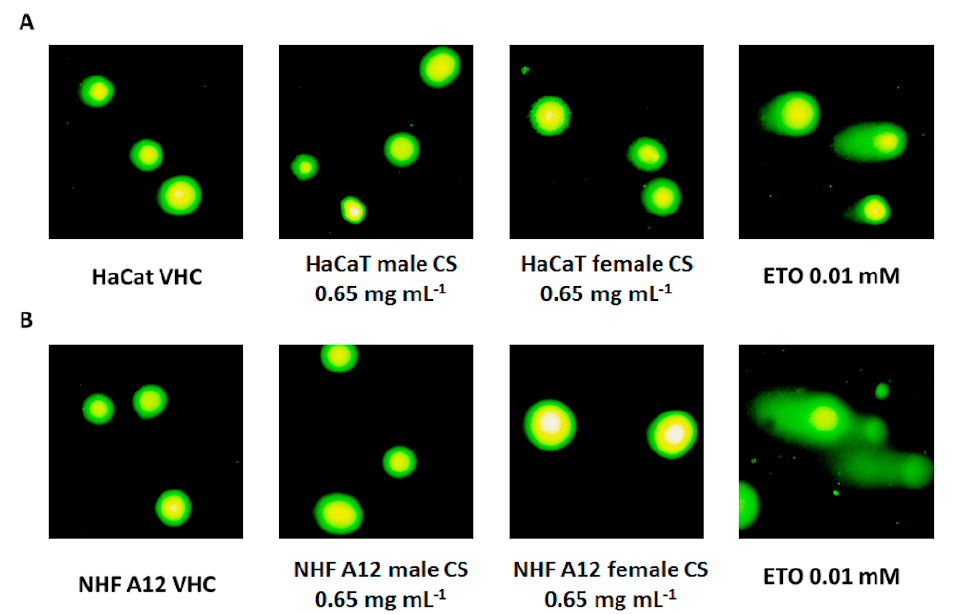
Figure 5. Comet assay. ( A ) HaCaT and ( B ) NHF A12 cell lines were treated with EOs from female and male inflorescences of cv CS at 0.65 mg mL − 1 and cell damage was analyzed by Comet assay, 24 h post-treatment. ETO was used as a positive control.